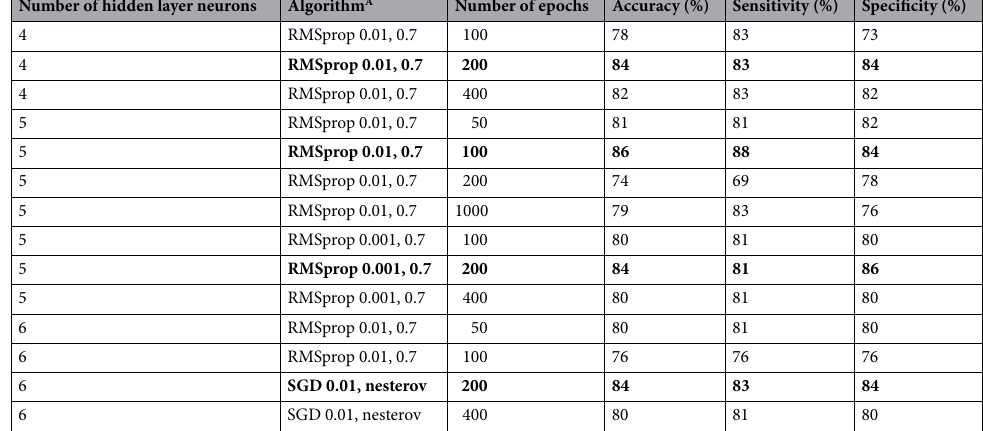
Table 4. Six-sensor model classification results. Bold lines indicate best-performing networks. A Algorithm name and parameters: learning rate and momentum coefficient/type.